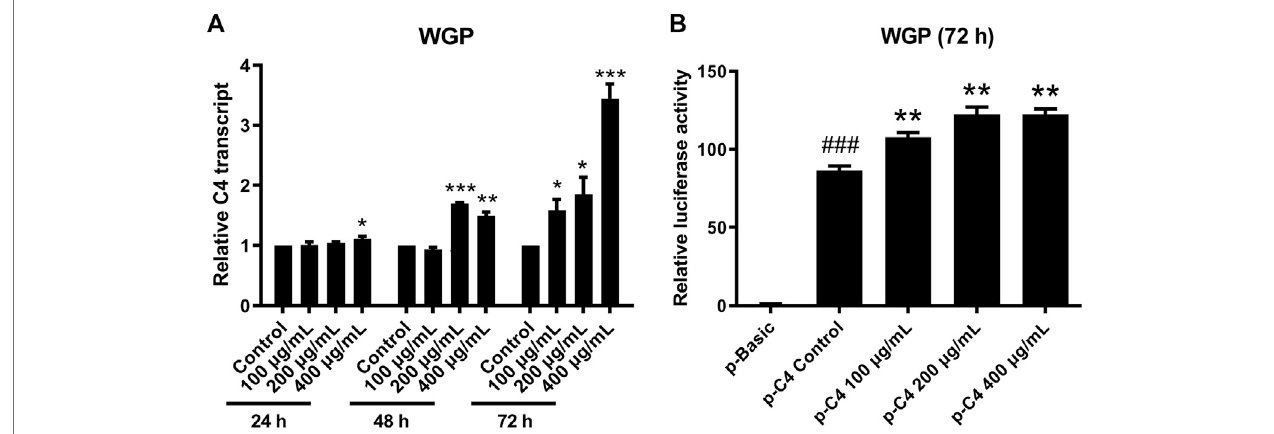
FIGURE5| WGPpromoteC4genetranscription.L-O2cellsweretreatedwithWGPataseriesofequalratiogradientconcentrationsforupto72 h.Real-timePCR method was used to detect the levels of C4 transcripts (A) . L-O2 cells was transiently transfected with the full-length pC4 -1,007/+75 (p-C4) plasmid and then treated withWGP or vehicle controlfor 72 h. Luciferase assays were performed to determine theC4 promoter activity (B) . Dataare presented as mean oftriplicates ± SEMfrom one representative experiment. * indicates p < 0.05, ** indicates p < 0.005, and *** indicates p < 0.001 compared to vehicle control. ### indicates p < 0.001 compared to the basic vector control.